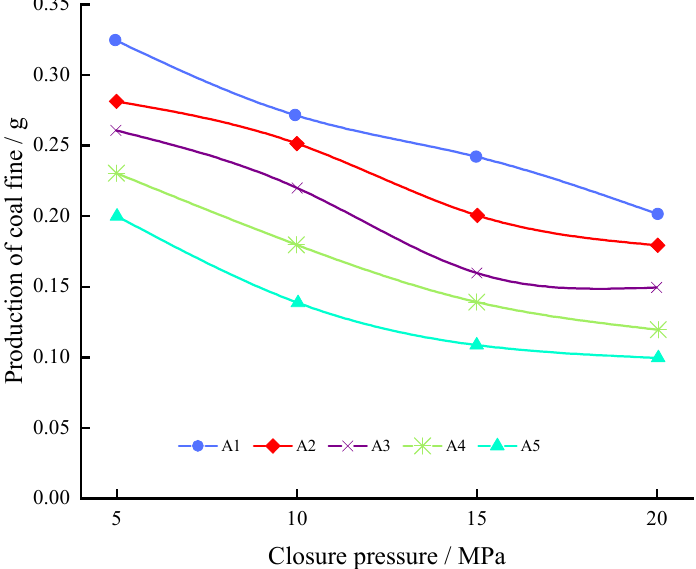
Figure 7. Effect of fiber addition on coal powder production under different closing pressure con- ditions.